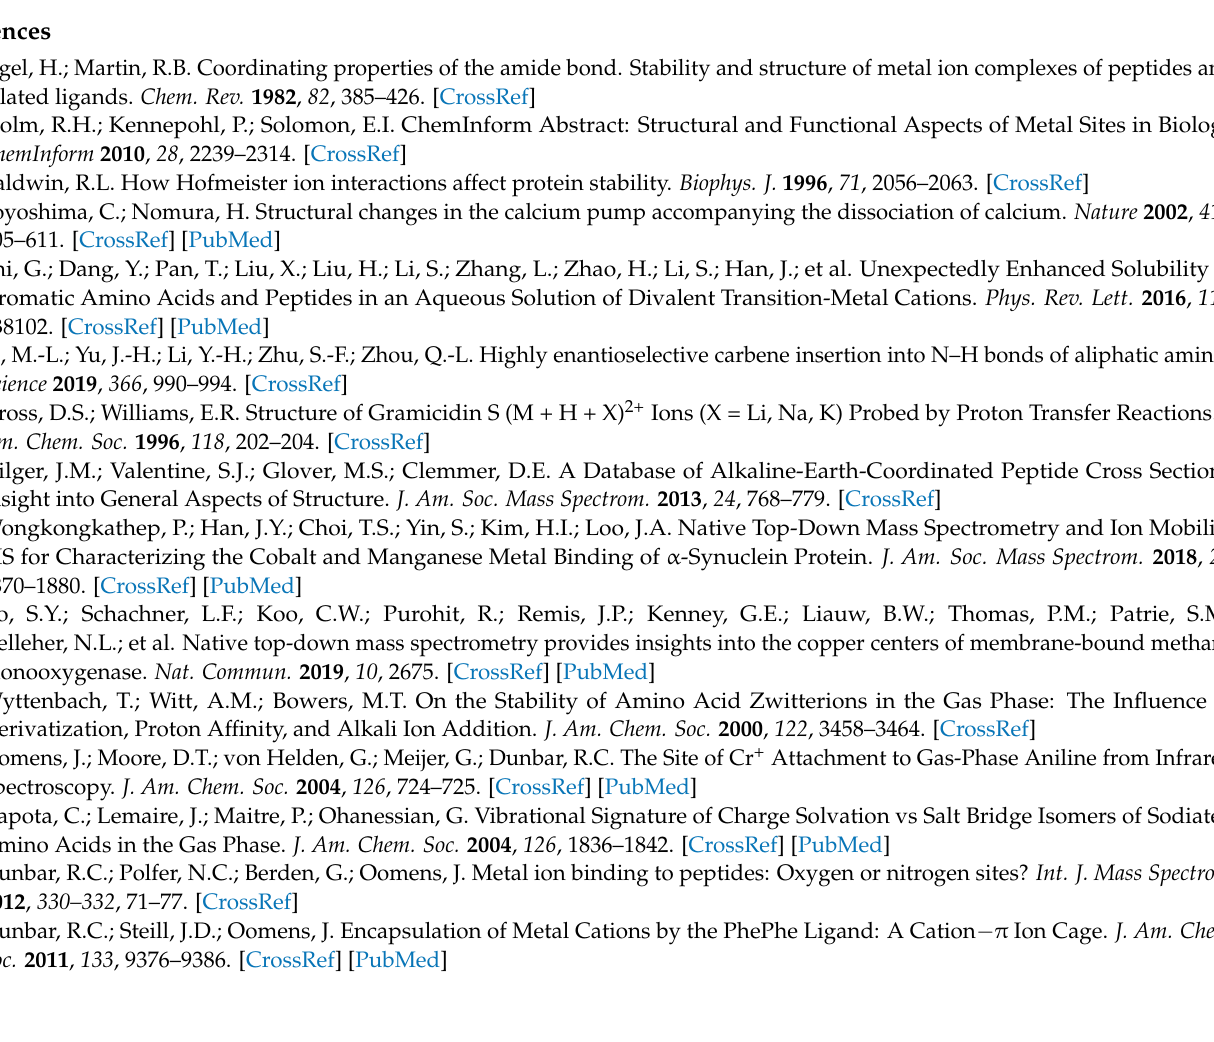
Table S1: relative energies of the 80 isomers, Table S2: Cartesian coordinates of some structures ( 1 a / b ~ 3 a / b , 23 a / b , 24 a / b ), Figure S1: mass spectra, Figure S2: structures of the 80 isomers, Figure S3: IR spectra of some isomers based on the MP2 method, Figure S4: the predicted vibrational spectra of the top isomers of 4 a / b ~ 16 a / b